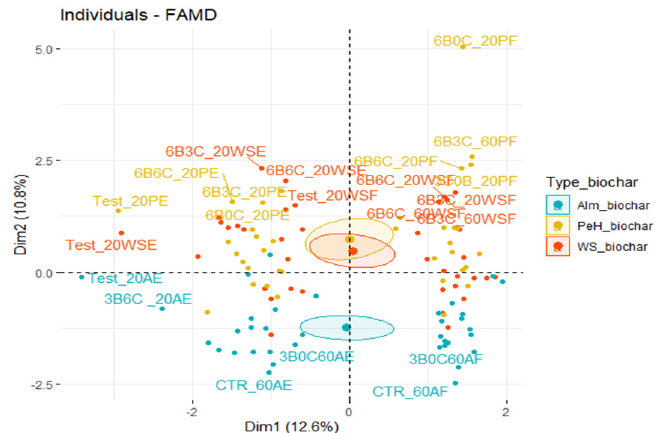
Figure 2. Score plot demonstrating the impact of multiple biochars on soil pH and electrical conductivity in a plastic pot at the start of planting and the conclusion of the research.